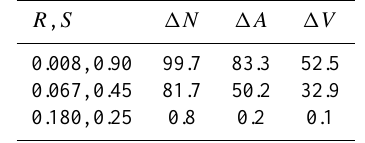
Table 2. Fractional particle number, 1N , surface area density, 1A , and volume density, 1V , (in %) of all particles smaller than 0.1µm in the case of three normalized (with number density N = 1 particle per cm 3 ) lognormal particle size distributions (background condi- tions with (a) median radius R = 0 . 008µm and distribution width S = 0 . 90; (b) R = 0 . 067µm, S = 0 . 45; (c) R = 0 . 180µm, S = 0 . 25). The definition of the size distribution parameters N , R , and S and Sect.